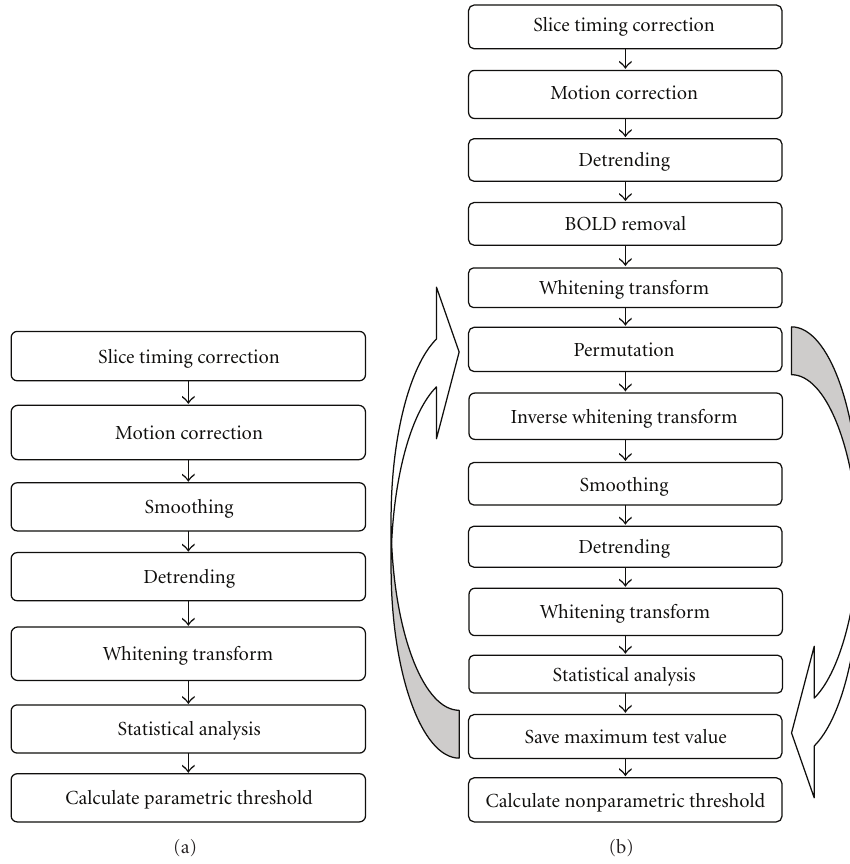
Figure 4: (a) Flowchart for conventional parametric analysis of fMRI data. (b) Flowchart for nonparametric analysis of fMRI data. In each permutation a new null dataset is generated and analysed.